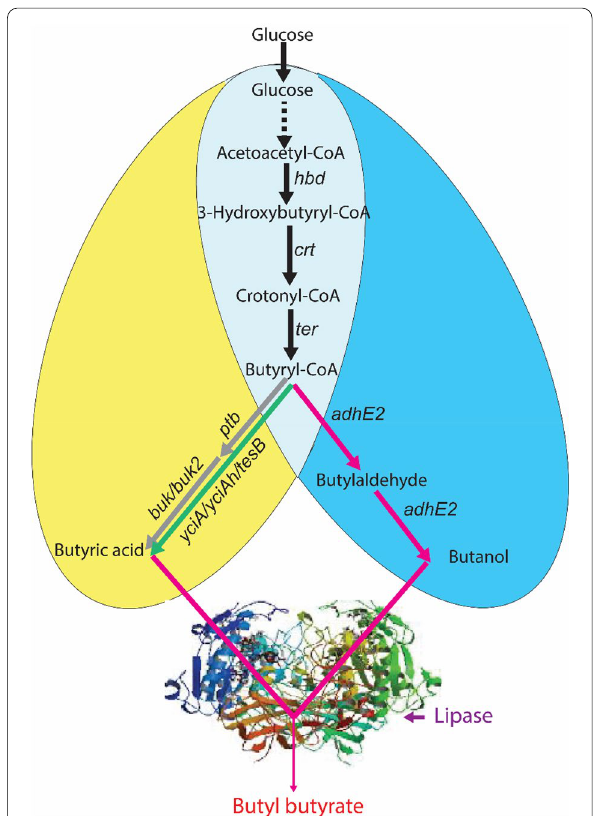
Fig. 1 Construction of a “diamond-shaped” consortium for the direct production of butyl butyrate from glucose using two E. coli strains with the same genetic background. The butyric acid-producing strain is shown in yellow, and the butanol-producing strain in blue. A shared pathway from glucose to butyryl-CoA is shown in light grey in overlap between the two strains. A green arrow indicates the thioesterase pathway (encoded by yciA, yciAh or tesB ), while the ptb - buk and ptb - buk2 route is indicated by a grey arrow. The production routes of precursors (butanol and butyric acid) and their conversion into butyl butyrate with the assistance of lipase enzyme forms a “diamond-shaped” structure, which was used to define the consortium. The genes hbd (3-hydroxybutyryl-CoA dehydrogenase), crt (crotonase), adhE2 (aldehyde/alcohol dehydrogenase), ptb (phosphate butyryltransferase), as well as buk and buk2 (butyrate kinase) are derived from C. acetobutylicum ; the ter gene (trans-enoyl-CoA reductase) is from Treponema denticola; yciA and tesB (acyl-CoA thioesterase) are from E. coli ; yciAh (acyl-CoA thioesterase) is from Haemophilus